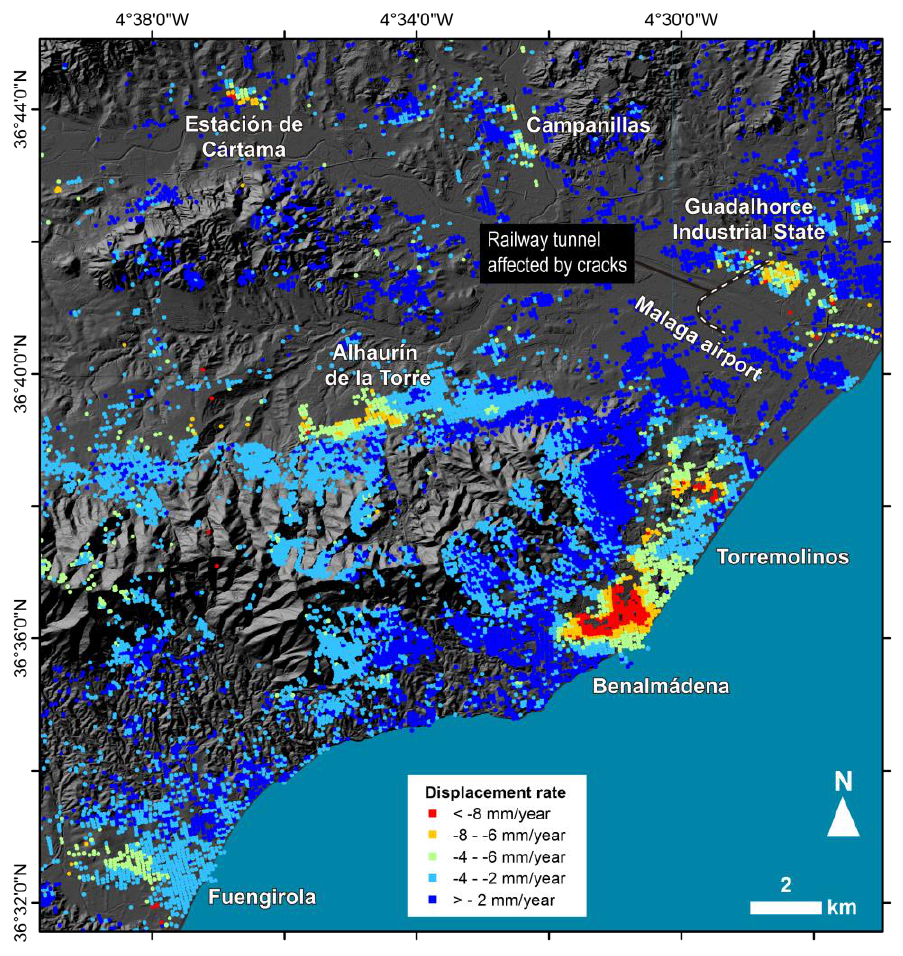
Figure 10. GEP map data of the West of Malaga. The areas with displacements included in the text are located. Note the clear movements detected between the Benalmádena and Torremolinos municipalities not analyzed neither mentioned in press reports so far.